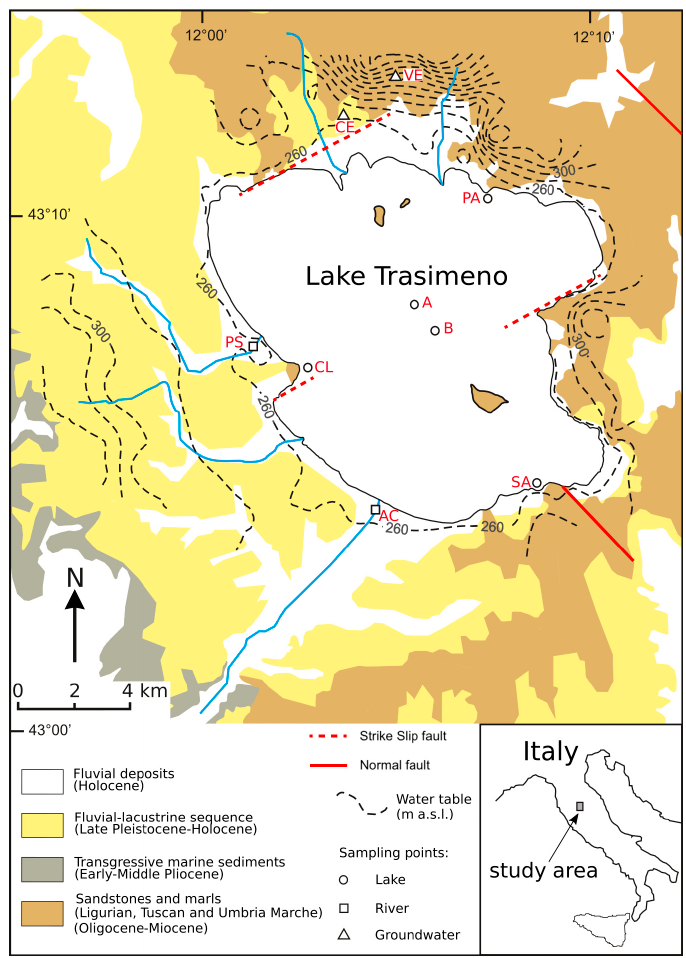
Figure 2. Geolithological map [28,29,32]. In the same map are also reported the elevation of the water table [33] and the location of sampling points (CL—Castiglione del Lago, SA—Sant’Arcangelo, PA—Passignano, AC—Anguillara Channel, PS—Paganico stream, VE—Vernazzano well, CE—Cerrete spring; A and B are the locations of the vertical profiles).